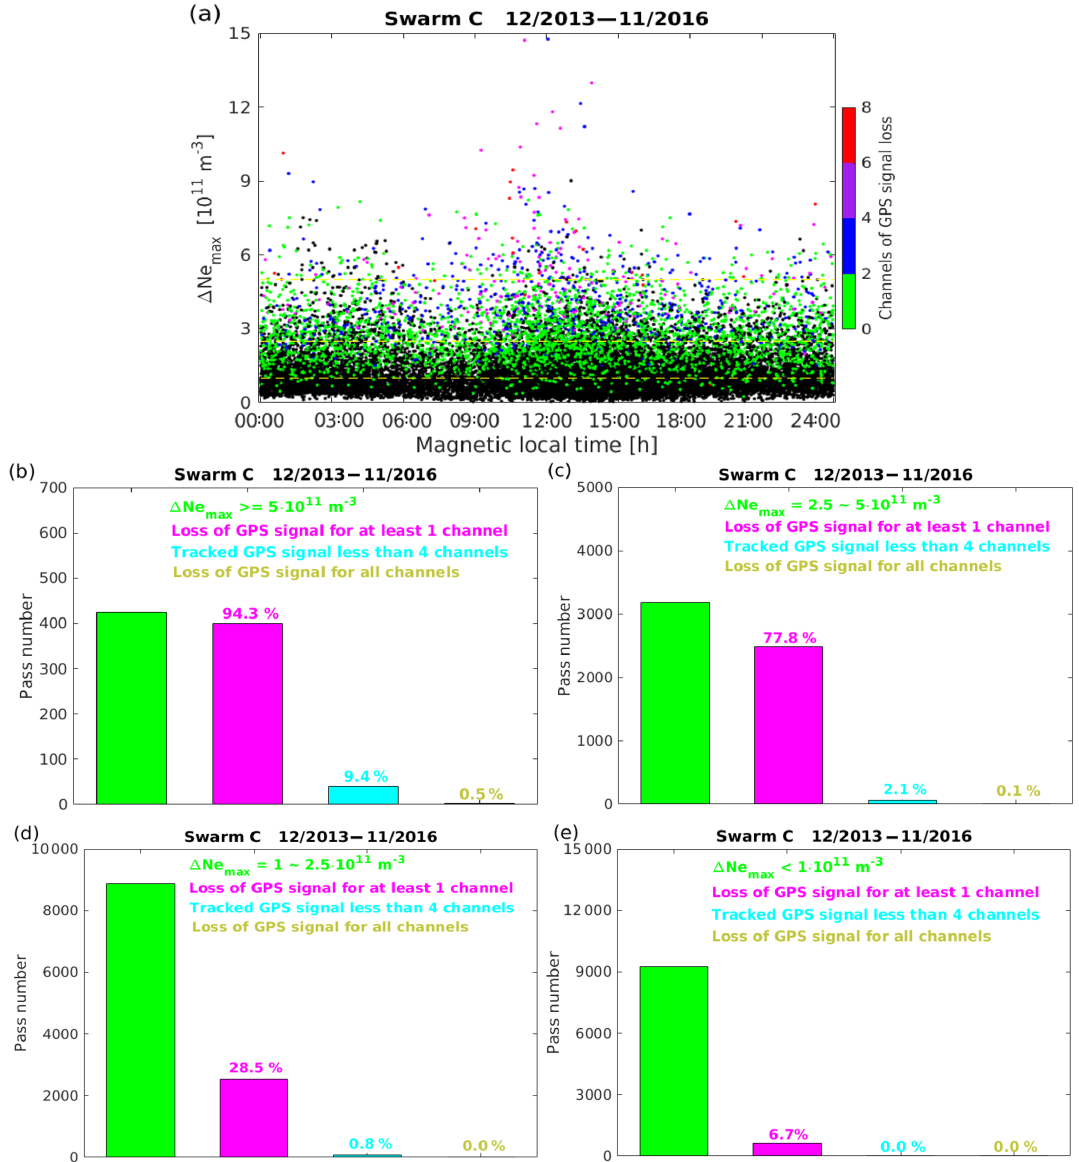
Figure 5. (a) The MLT distribution of the maximum density gradients ( (cid:49) Ne max ) determined from orbital arcs within | MLAT | ≥ 50 ◦ and the (cid:49) Ne max corresponds to GPS signal loss at different numbers of channels marked with different colors. (b) The orbital arcs with (cid:49) Ne max ≥ 5 × 10 11 m − 3 are indicated with green bars, and the ratio of simultaneously occurring GPS signal loss for at least 1 channel or all channels, as well as the traced GPS signal of less than four channels, are indicated by different colors. (c) and (d) are similar to (b) but the threshold of (cid:49) Ne max has been changed from 2 . 5 × 10 11 to ∼ 5 × 10 11 and from 1 × 10 11 to ∼ 2 . 5 × 10 11 m − 3 , respectively. (e) is similar to (b) but only the orbital arcs with (cid:49) Ne max < 1 × 10 11 m − 3 have been taken into account.